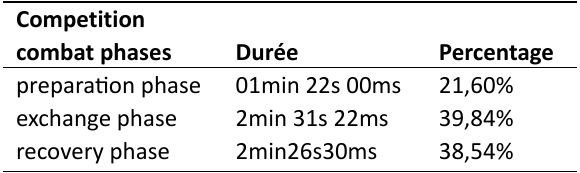
Table 7. Evaluation of the combat phases in the